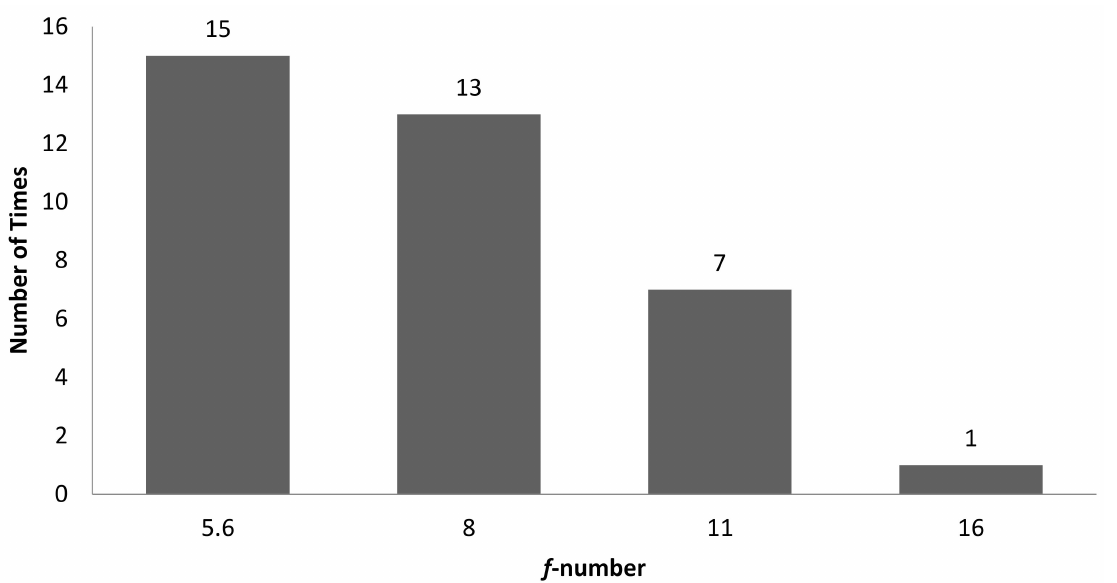
Figure 13. Bar chart showing the number of times correlation with R 2 ≥ 0.7 occurred for each f -number setting for an illumination angle of 45 ◦ for experimental setup